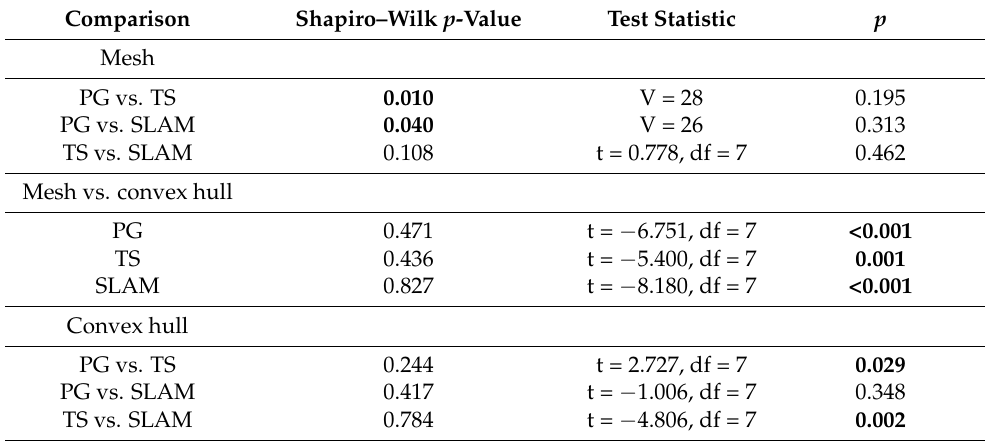
Table 5. Wilcoxon signed-rank tests for differences in mesh and convex hull volumes. Bold values are significant at α =